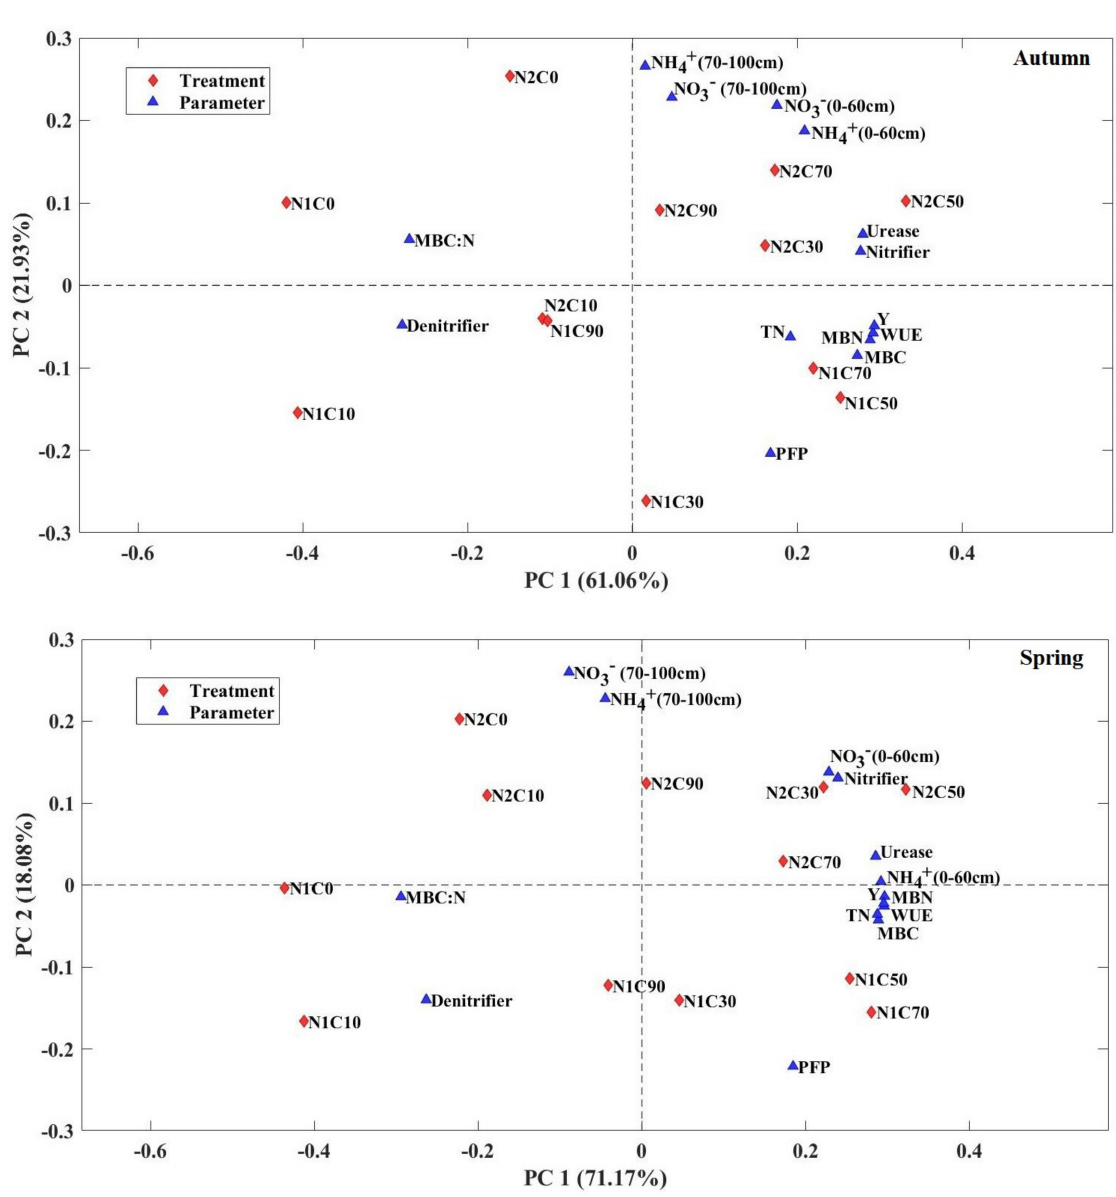
Figure 8. Principal component analysis (PCA) of the selected parameters measured on tomato plants grown with biochar (C0, C10, C30, C50, C70, and C90) with nitrogen fertiliser (N1 and N2). The parameters were urease enzyme activity (Urease), the number of amoA-type nitrifiers (Nitrifier), the number of nirS-type denitrifiers (Denitrifier), microbial biomass carbon (MBC), microbial biomass nitrogen (MBN), microbial biomass C:N (MBC:N) ratio, NO 3 − (0–60 cm), NO 3 − (70–100 cm), NH 4+ (0–60 cm), NH 4+ (70–100 cm), total N uptake of tomato plant (TN), yield of tomatoes (Y), water use efficiency (WUE), and partial-factor productivity of nitrogen